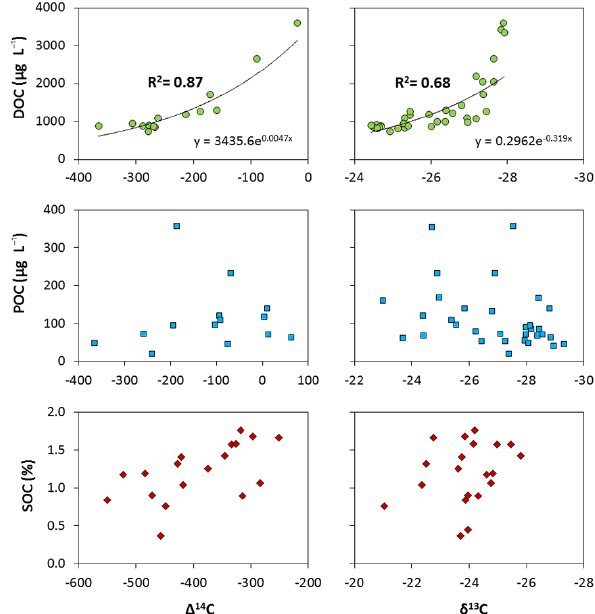
Figure 6. Relationships between organic carbon and (cid:49) 14 C and δ 13 C signatures in the DOC (green circles), POC (blue squares) and SOC (red